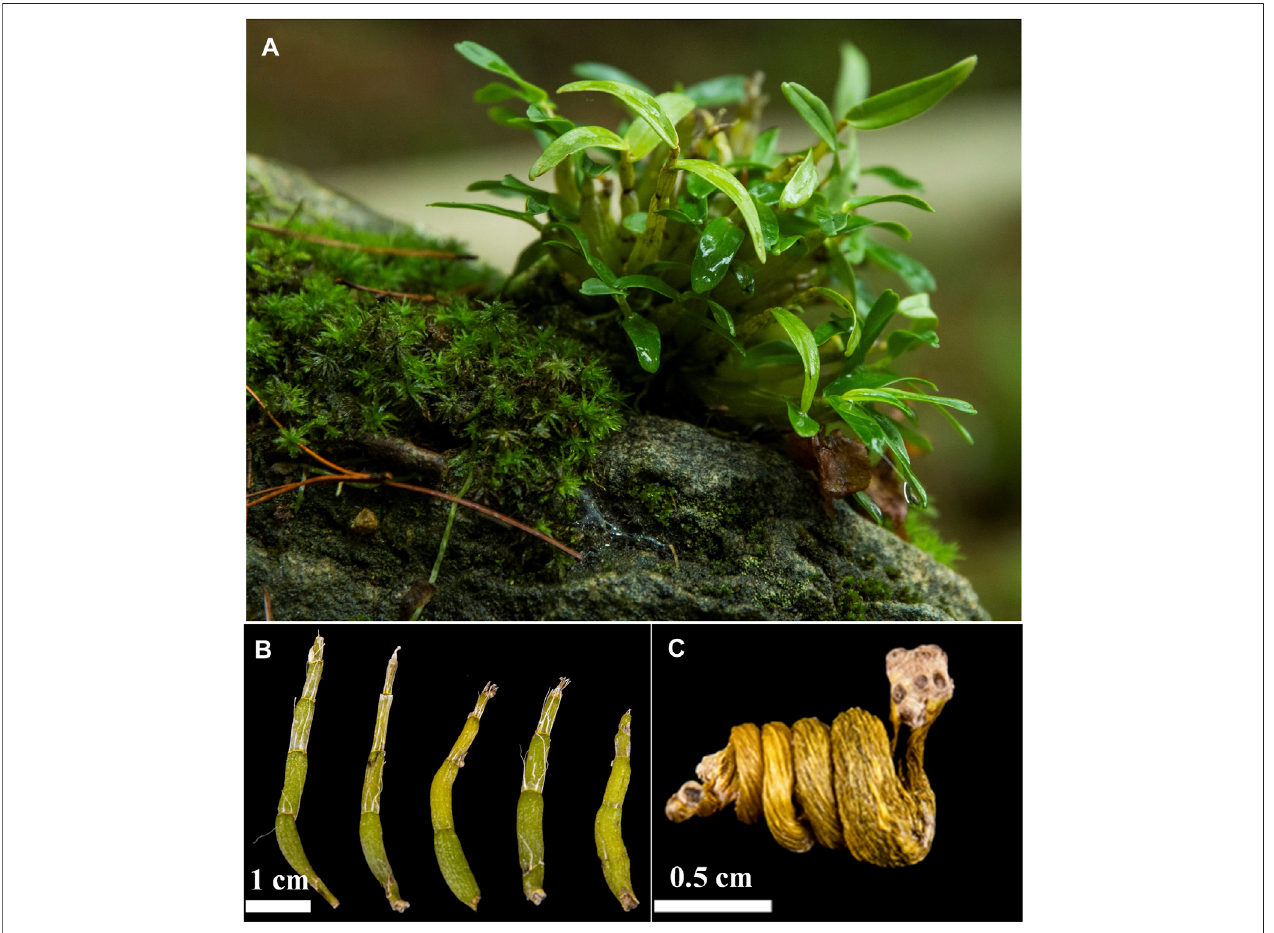
FIGURE 1 | The whole plant (A) , fresh strips (B) , and the commercial product named Fengdou (C) of D. huoshanense .